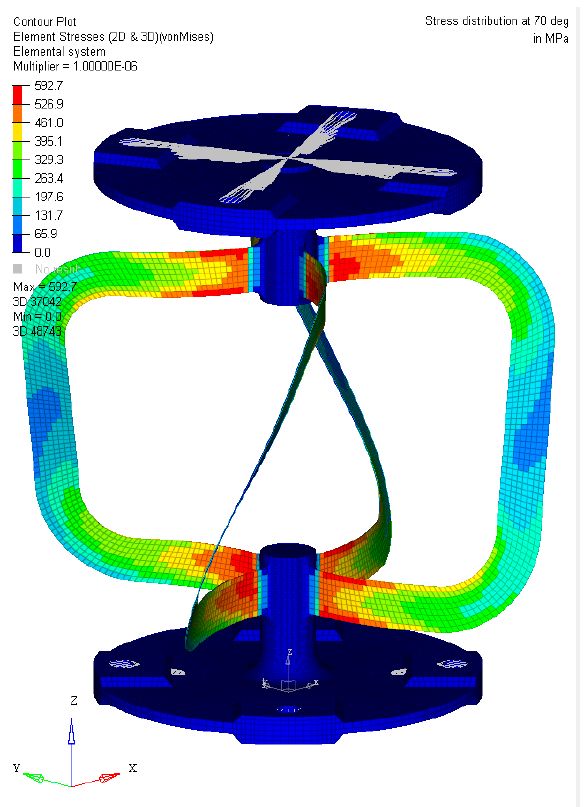
Figure 26. Overview of stress at the flexure hinge by 70°.